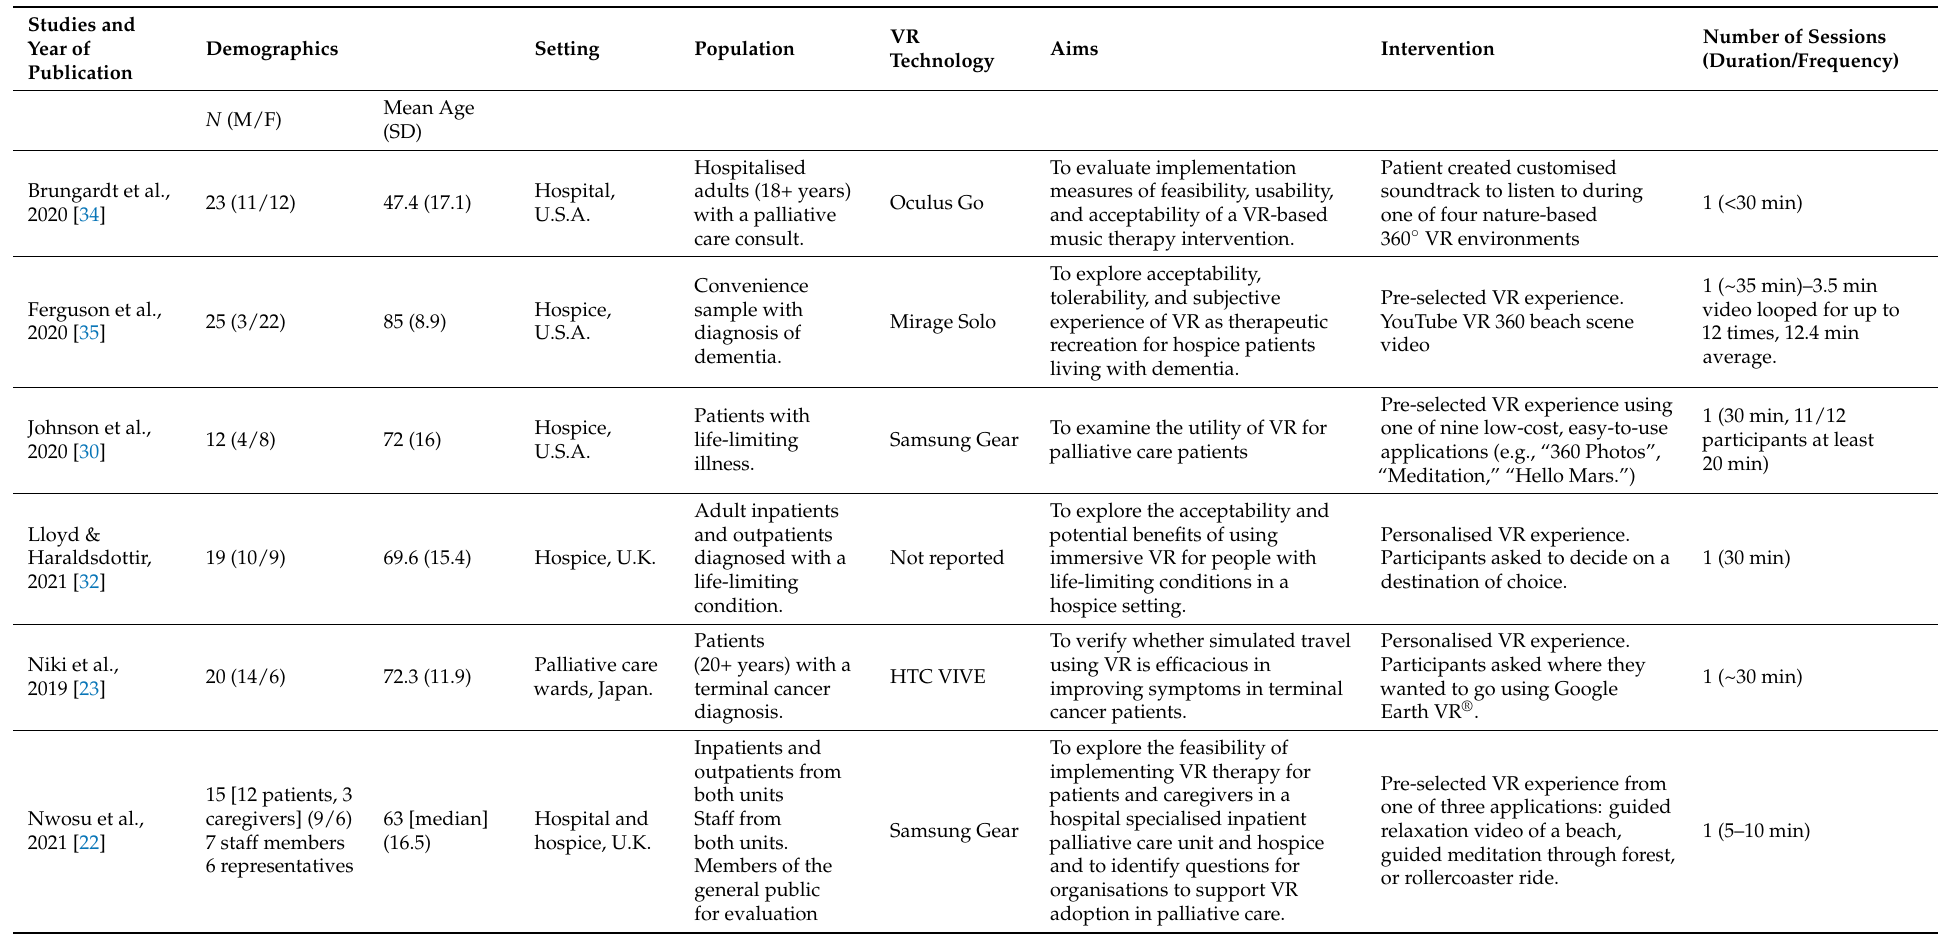
Table 1. Virtual reality in palliative care studies: demographics, setting, VR technology, aims, intervention, and number of